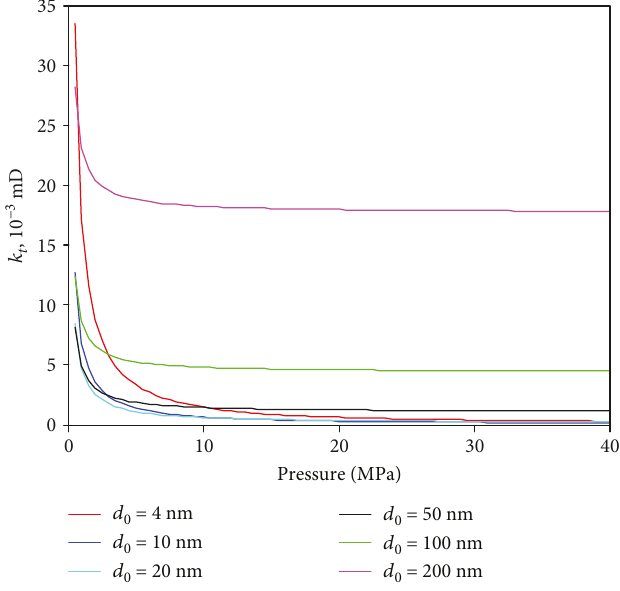
Figure 12: Apparent permeability of shale nanopores of di ff erent